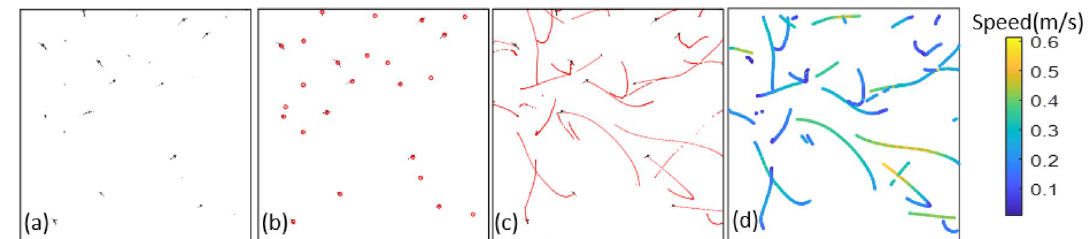
Figure 6. Demonstration of videogrammetry based estimation of flight speeds of free-flying mosquitoes. ( a ) and ( b ) are individual snapshots of a mosquito group and mosquito location identification results, respectively. ( c ) and ( d ) are mosquito trajectories composed of male Aedes over 100 frames without and with flight speed information,